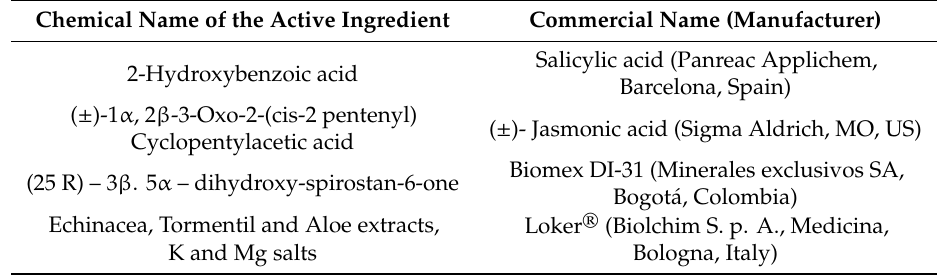
Table 2. Chemical name of the active ingredient, commercial name, and manufacturer of the synthetic resistance elicitors used to evaluate the foliar sprays on cape gooseberry plants inoculated with Fusarium oxysporum f. sp. physali